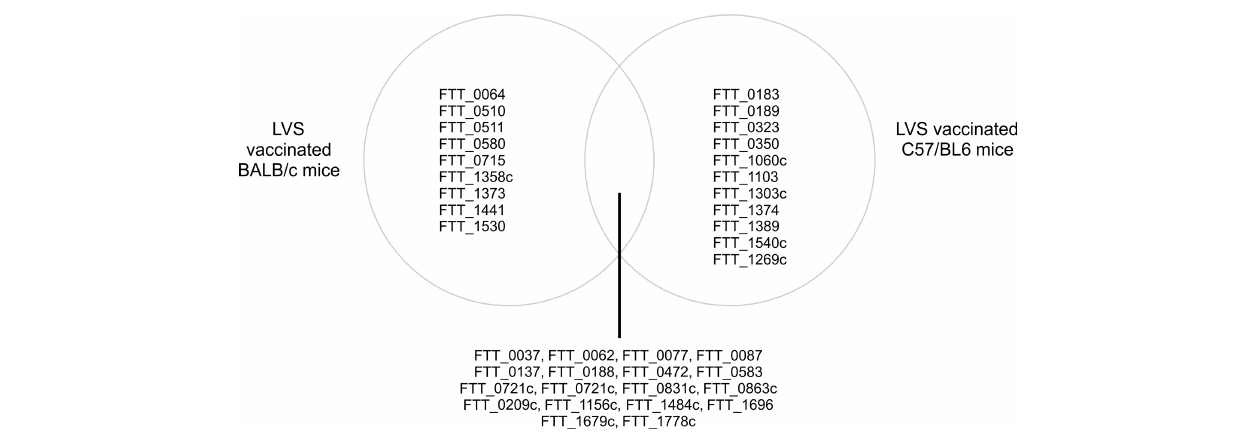
FIGuRE 2 | Venn diagram showing the intersection of immunoreactive proteins observed to be reactive with sera from LVS vaccinated and protected BALB/c mice and LVS vaccinated and unprotected C57/BL6 mice